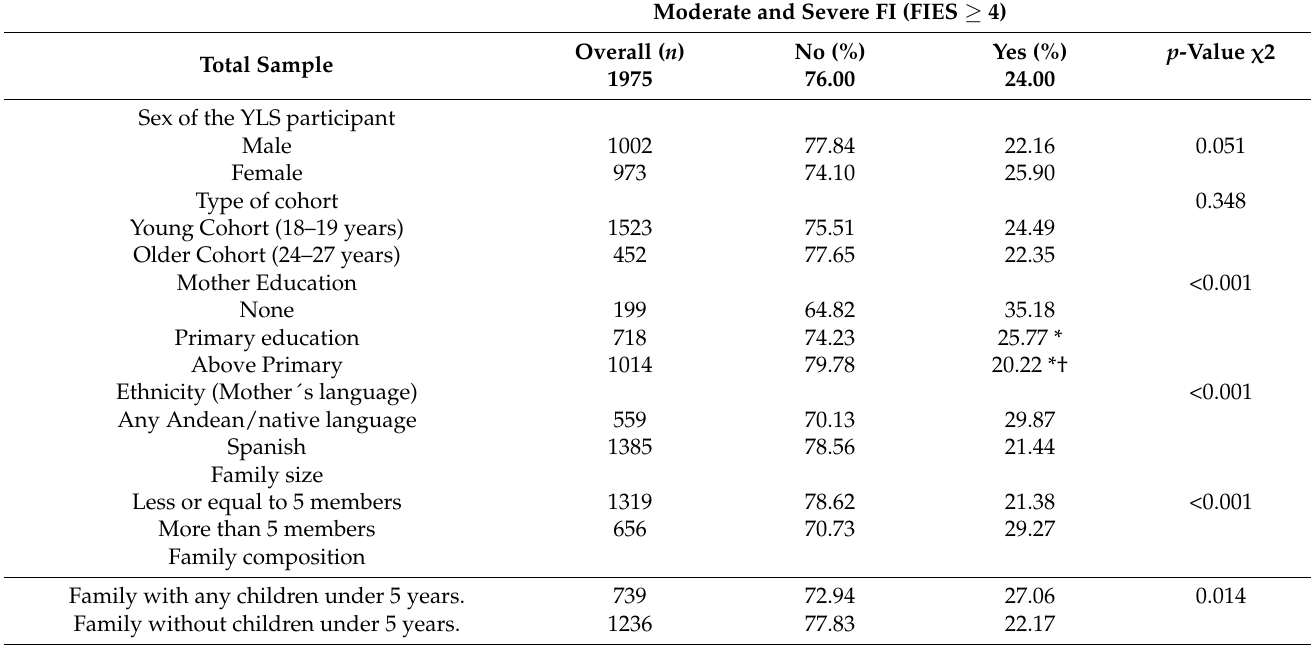
Table 1. Individual characteristics of the YLS participant by food insecurity status.